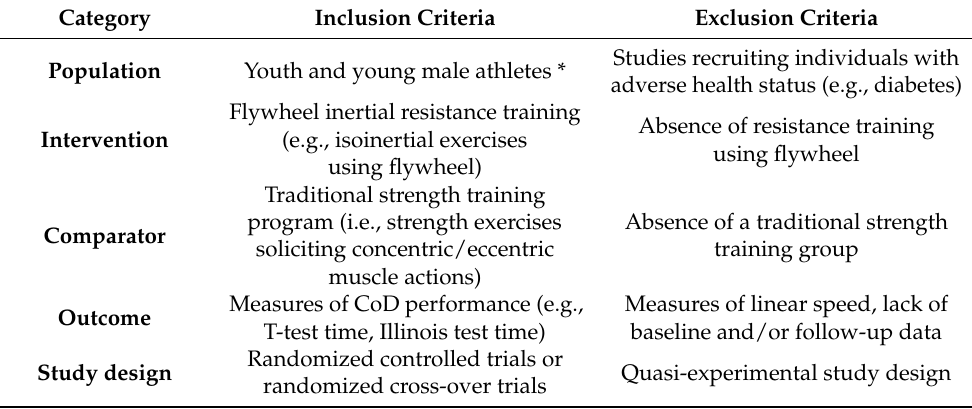
Table 1. Selection